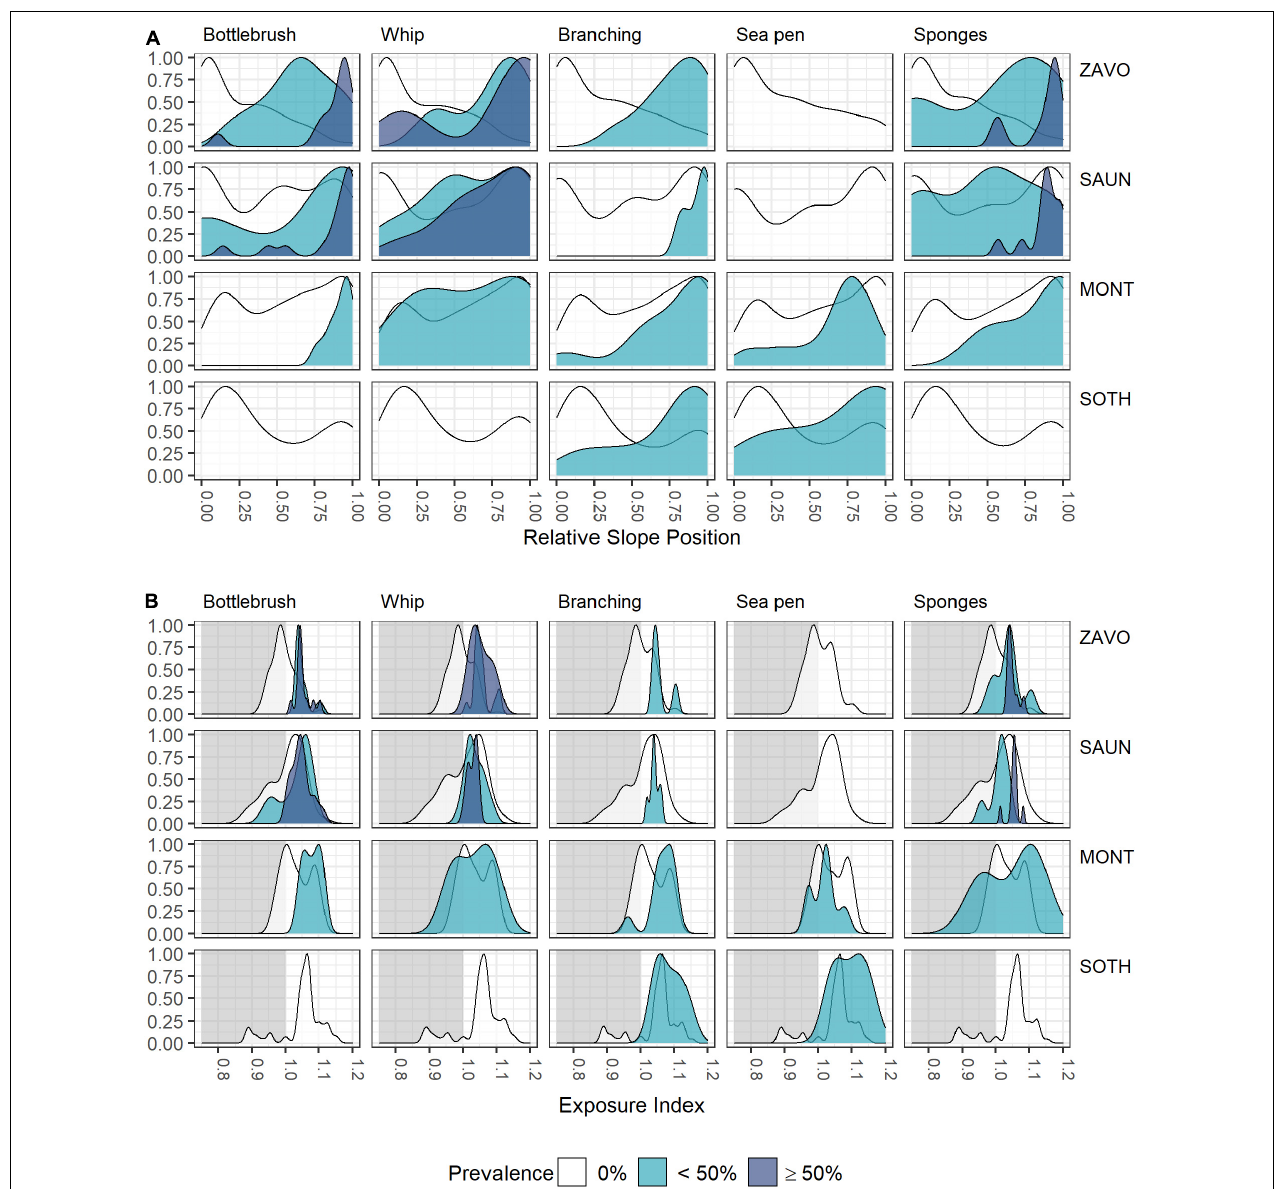
FIGURE 6 | Scaled density curves showing the frequency of OBIA objects with 0, < 50, or ≥ 50% prevalence of VME indicator taxa in intersecting images across the range of (A) Relative Slope Position and (B) Exposure